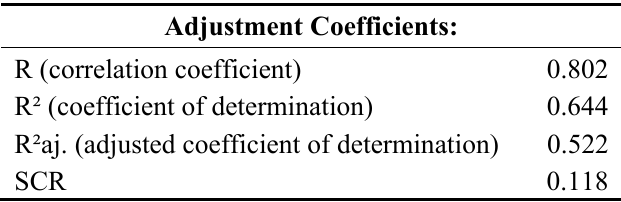
Table 13. ANCOVA of the SIM_Exp_Lang